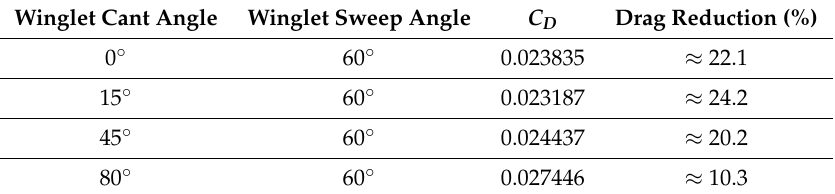
Table 5. C D and drag reduction percentage for a target C L equal to 0.3. The drag reduction percentage was computed with respect to the baseline wing (where positive values indicate drag reduction).